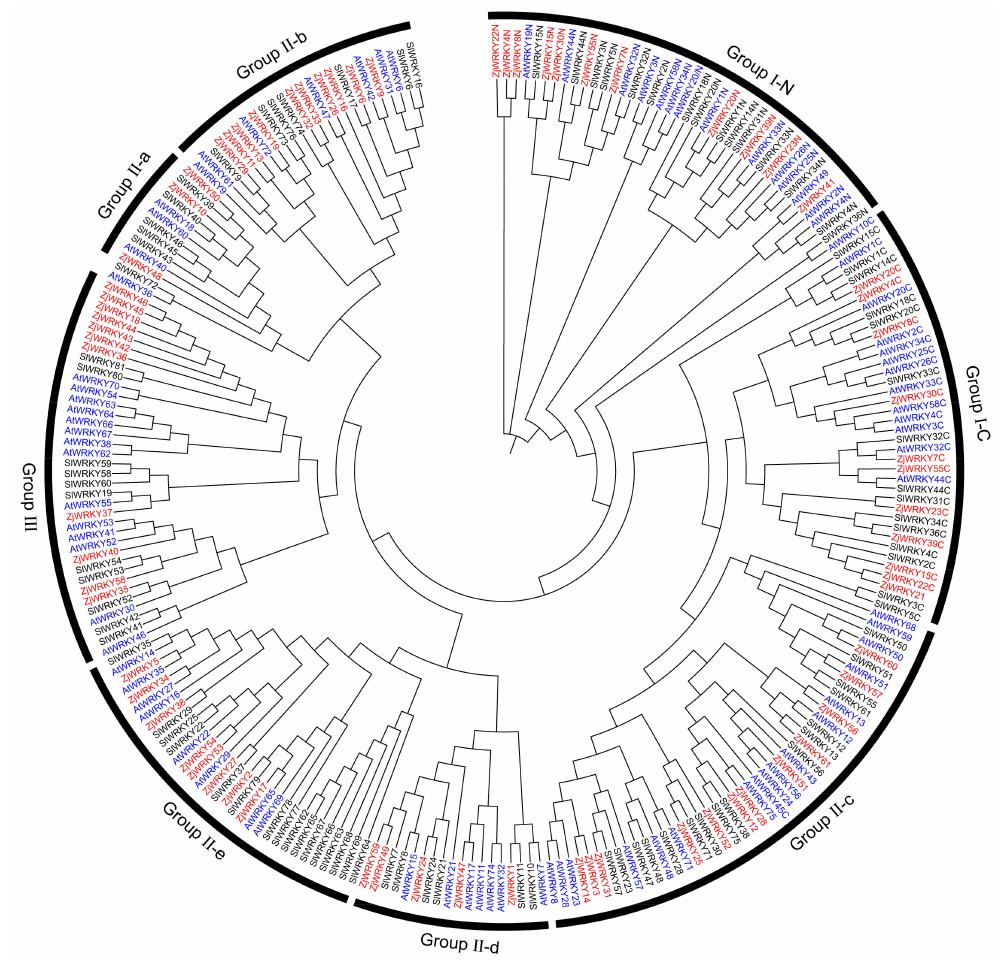
Figure 2. Phylogenetic analysis of the WRKY proteins from Ziziphus jujuba ‘Junzao’ jujube, Arabidopsis thaliana and Solanum lycopersicum . Multiple sequence alignments of WRKY amino acid sequences were performed using ClustalW. The phylogenetic tree was constructed using MEGA7.0 with the neighbor-joining method and 1000 bootstrap replicates (substitution model: Jones–Taylor–Thornton model). Group (I, II, III) and subgroup (IIa~IIe) names were marked outside the